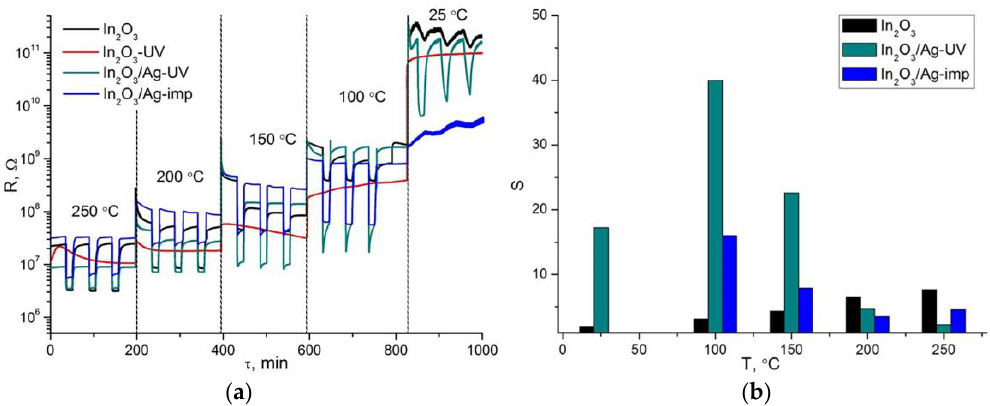
Figure 2. ( a ) Resistance of the In 2 O 3 samples and In 2 O 3 /Ag nanocomposites in the temperature range